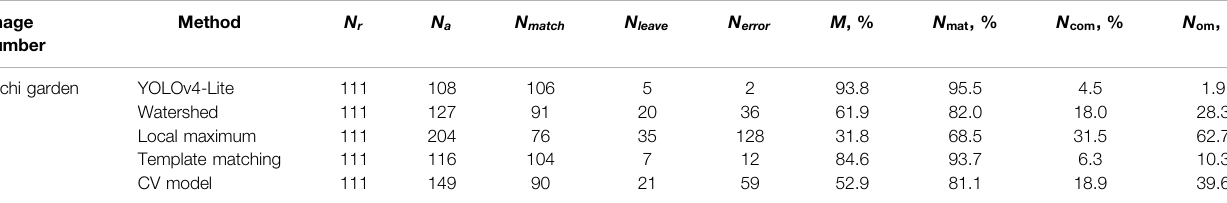
TABLE 6 | Litchi garden single-tree detection results ’ statistics. Image number